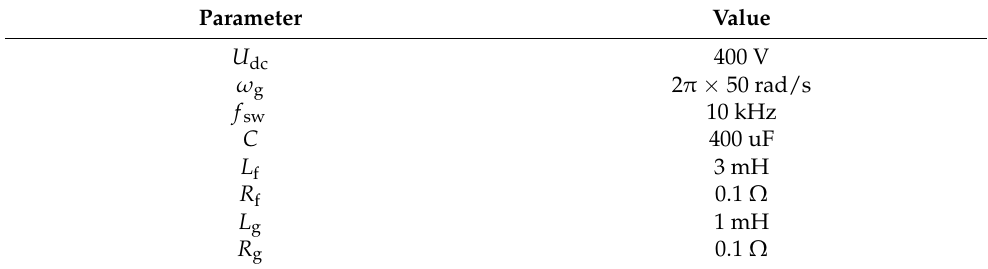
Table 1. System parameters.